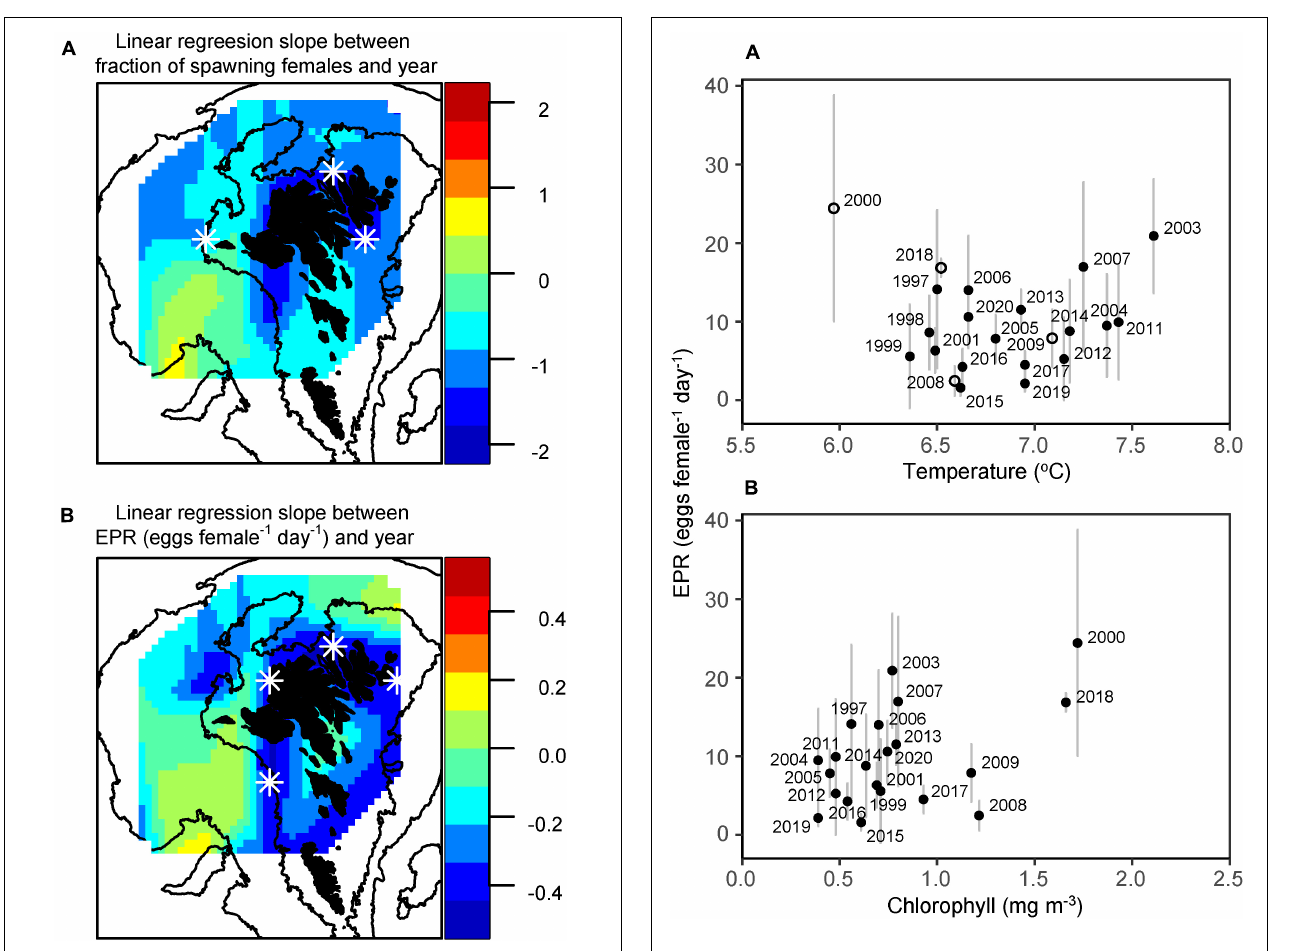
FIGURE 6 | Distribution of slopes of the linear regression for the change in (A) fraction of spawning females and (B) individual egg production rates (eggs female − 1 day − 1 ) as a function of year. Stars ( ∗ ) indicate locations where p < 0.1.